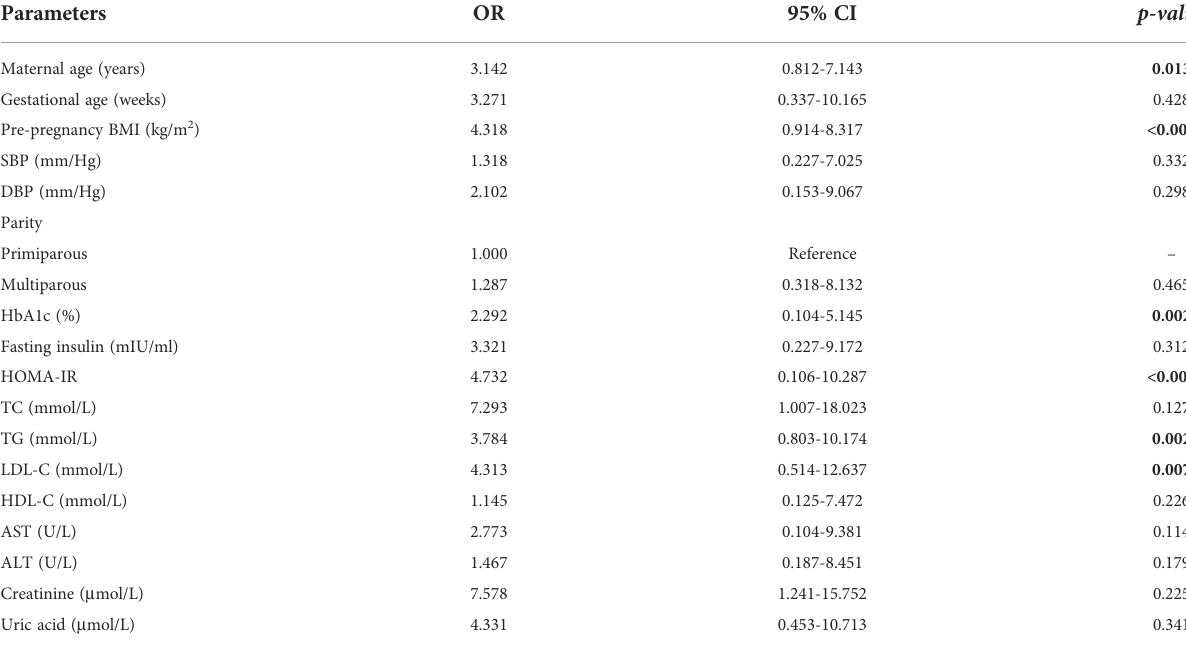
TABLE 3 Clinical and laboratory risk factors for GDM explored by univariable logistic